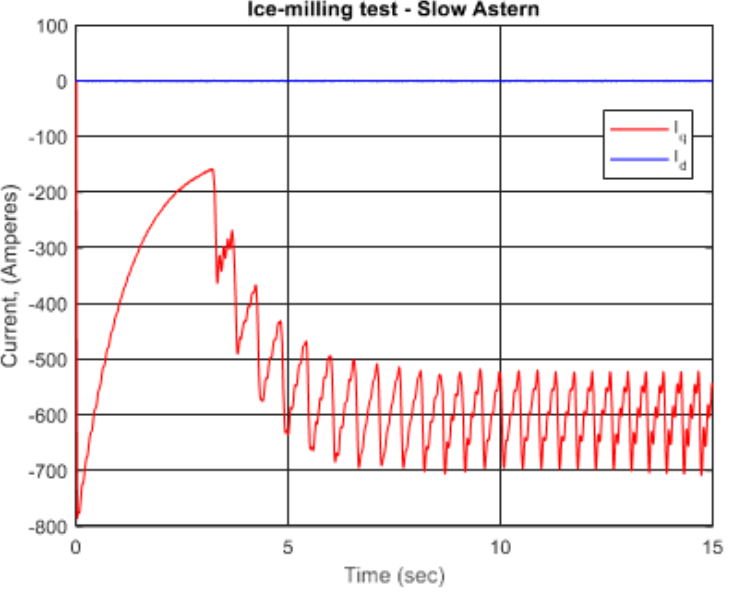
Figure 18. Motor performance during crash back test.